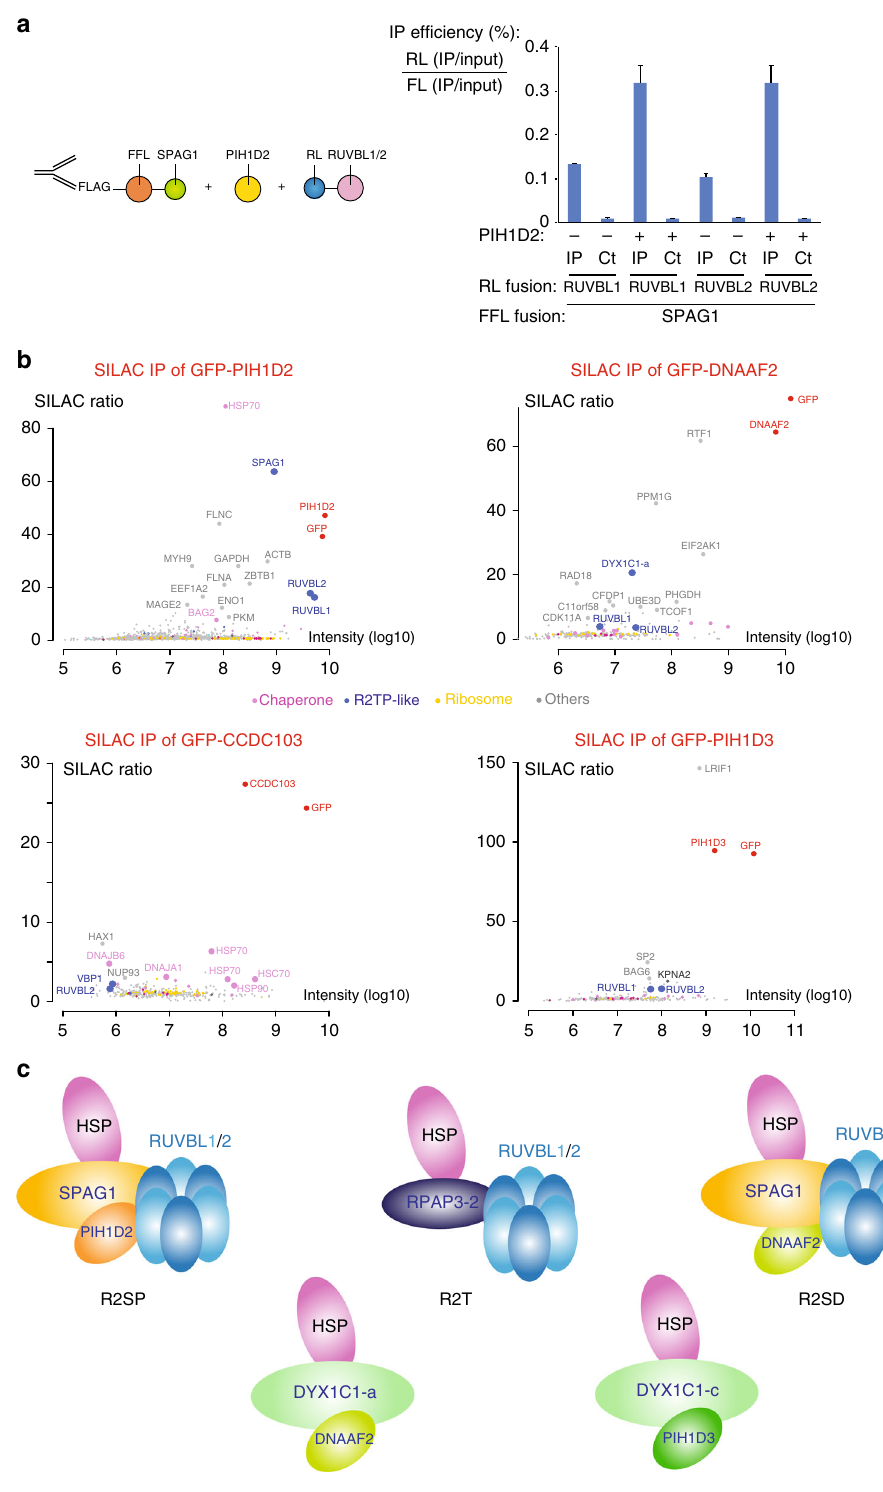
Fig. 5 Identi fi cation of R2TP-like complexes. a LUMIER interaction assays between SPAG1 and RUVBL1/2. Legend as in Fig. 3c excepted that an untagged PIH1D2 was co-expressed (lanes + ), or SMD1 as control (lanes − ). b SILAC proteomic analysis of the partners of GFP-PIH1D2, GFP-DNAAF2, GFP- CCDC103, and GFP-PIH1D3, performed in HeLa cells. Legend as in Fig. 2a. The color code is indicated between the graphs. c Models of possible R2TP- related